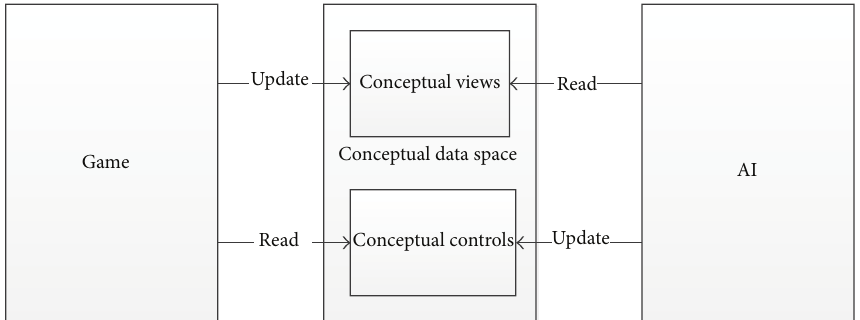
Figure 2: Basic architecture of a video game using conceptual AI. The game maintains a conceptual view of its internal state. A conceptual view is the projection of a part of the game state into conceptual space. Based on this conceptual data, the AI controls an agent in the game by issuing conceptual commands, which the game translates back into game actions.